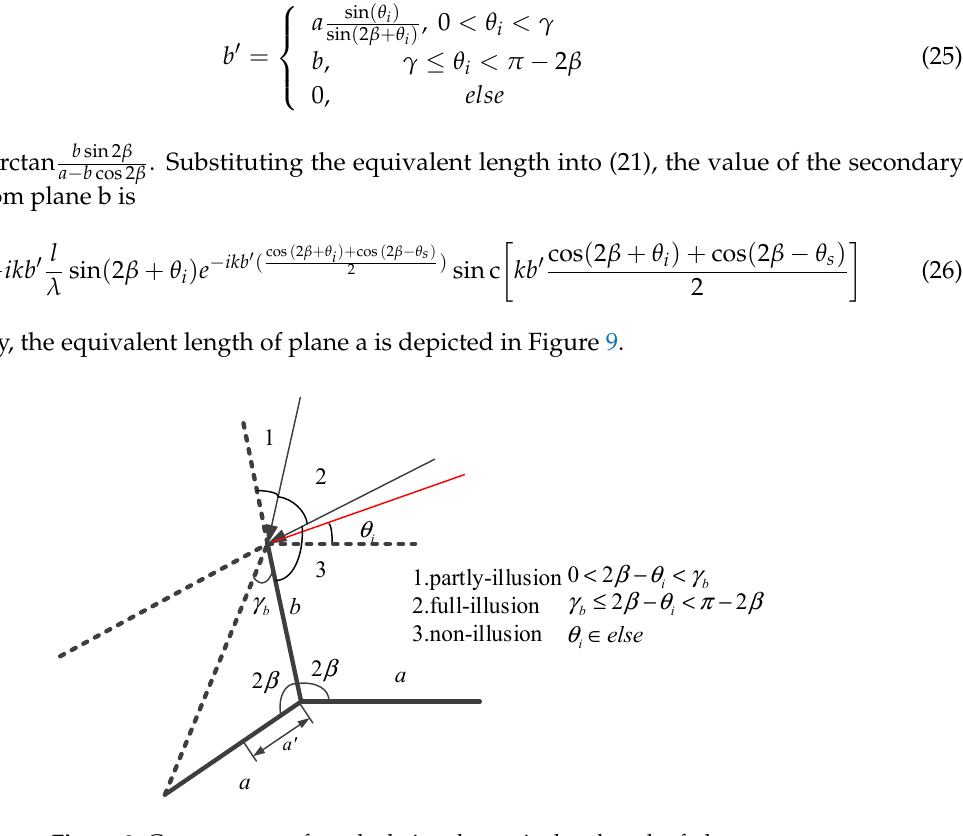
Figure 9. Geometry map for calculating the equivalent length of plane a.